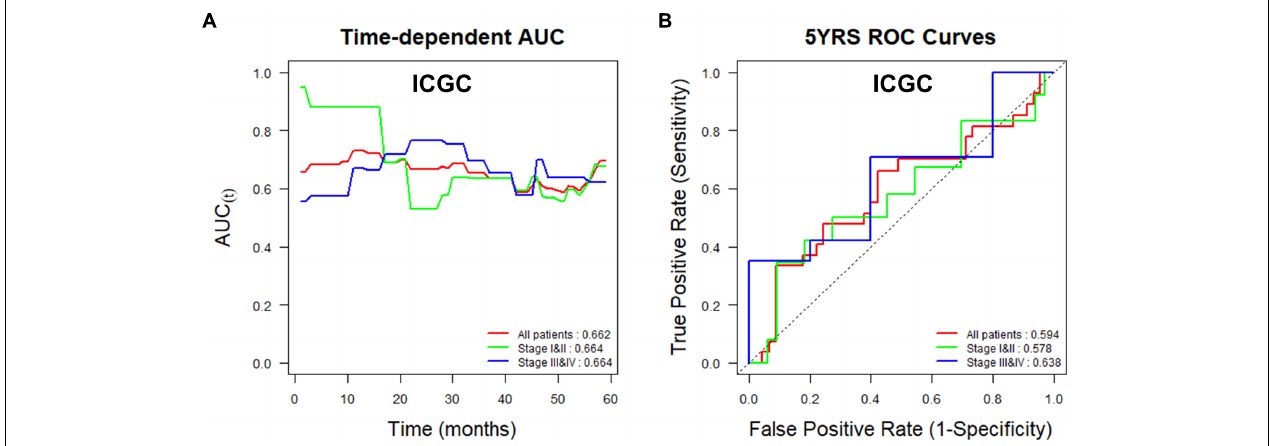
FIGURE 5 | Time-dependent area under the curve (AUC) and receiver operating characteristic (ROC) curves at 5 years according to TMED3 expression levels in the ICGC cohort. (A) Time-dependent AUC and (B) ROC curves at 5 years for patients in the ICGC cohort according to TMED3 expression levels. C-index values are shown at the bottom right in (A) . AUC values at 5 years are shown at the bottom right in (B) .